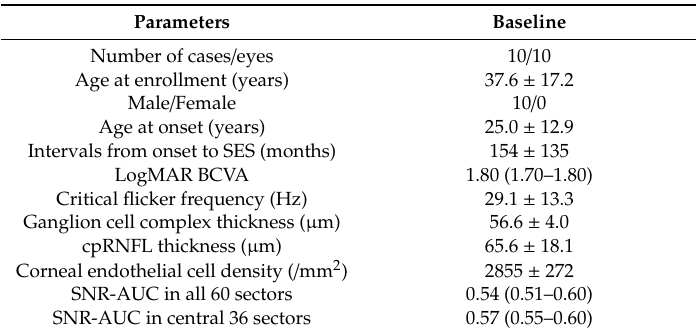
Table 2. Demographic and clinical characteristics of participants at